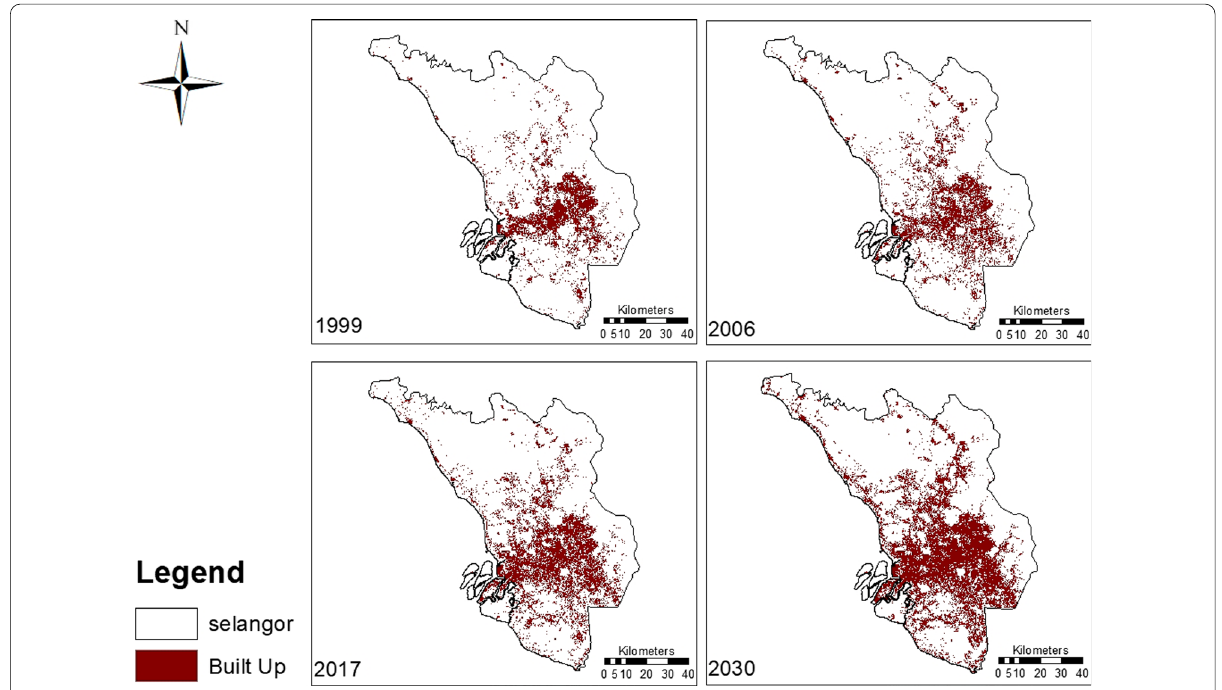
Fig. 9 The growth of built-up area for the period 1999 to